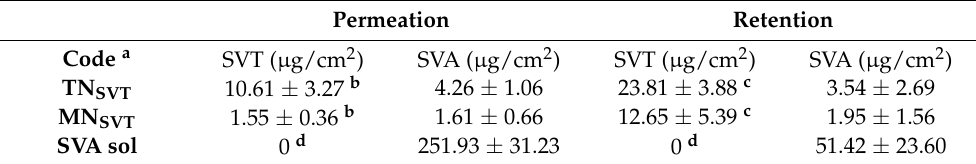
Table 3. SVT and SVA permeated across and retained within porcine sclera after 48 h.